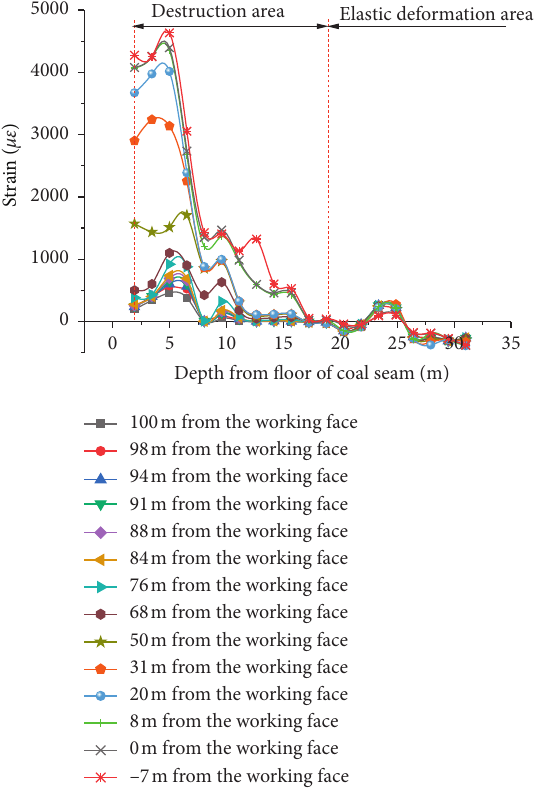
Figure 9: Strain variation curve of the floor at different distances from the working